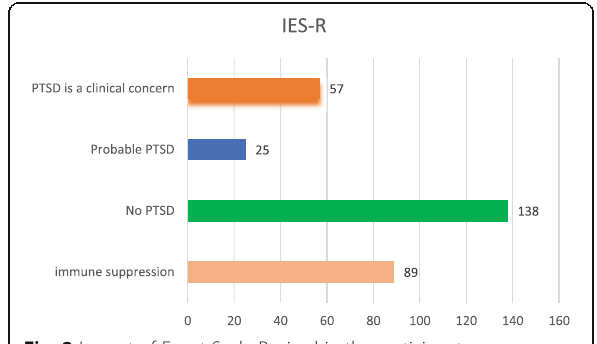
Fig. 2 Impact of Event Scale-Revised in the participants